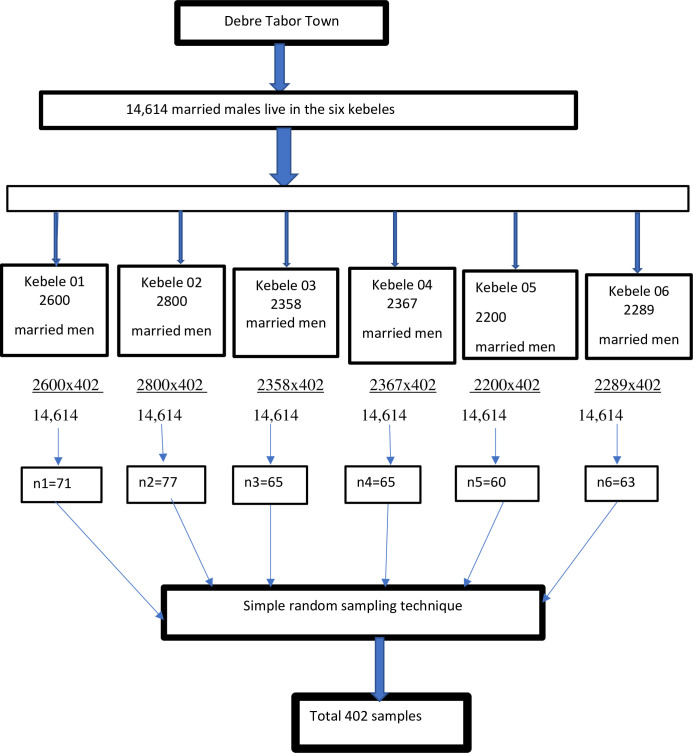
Schematic presentation of the sampling procedure for a study conducted on an intention to use vasectomy and its associated factors among married men in Debre Tabor Town North West Ethiopia 2019.